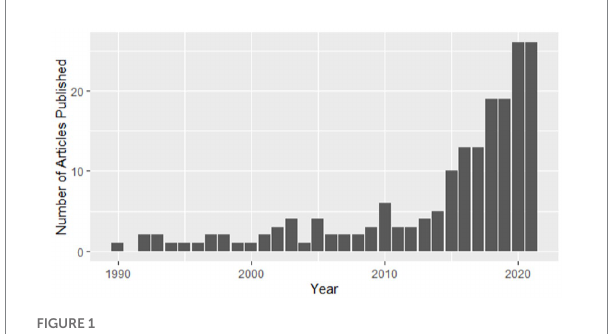
FIGURE 1 Articles published by date of publication.